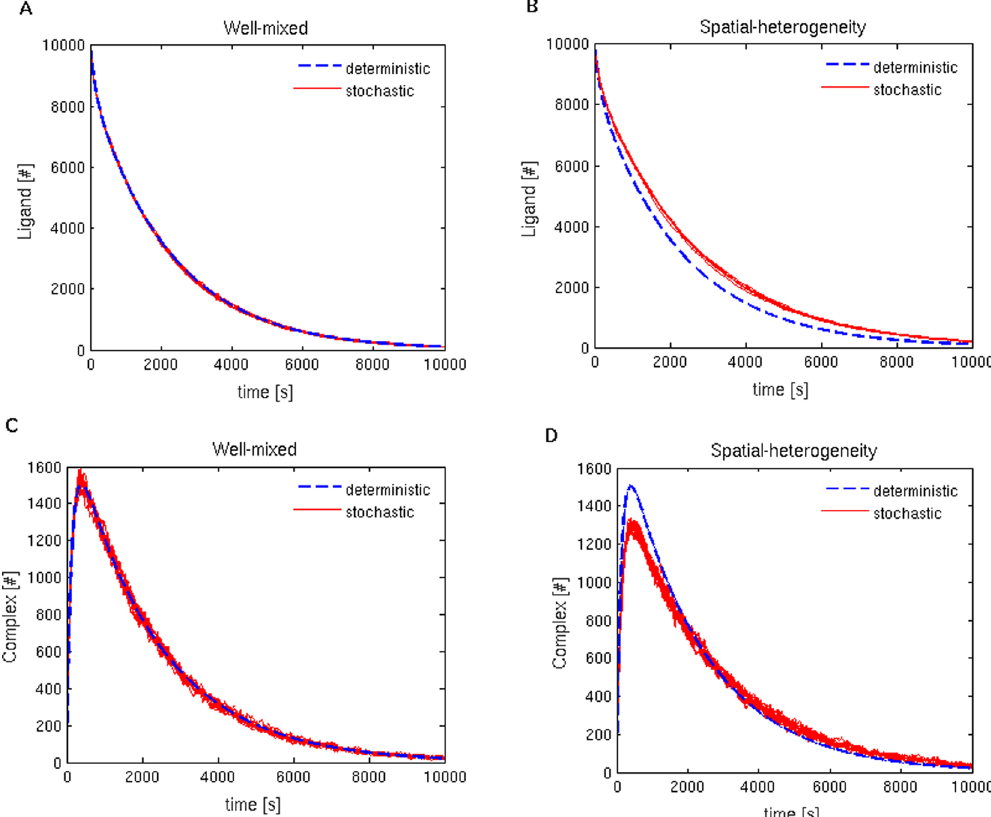
Figure 2. Total number of ligands and complexes in well-mixed and spatially-heterogeneous conditions. For the deterministic case, the time histories of the ligand and complex are obtained by solving the ordinary differential equations corresponding to the molecular interactions. For the well-mixed case, ( A , C ) 10 realisations of the exact stochastic simulation, using Gillespie’s direct method, are shown in red lines. ( B , D ) 10 realisations of the stochastic reaction-diffusion simulations, shown in red lines, using